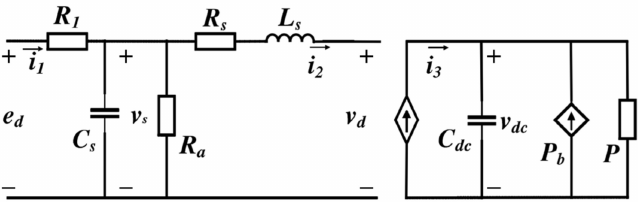
Figure 8. The equivalent model of AC/DC Hybrid Microgrids in discharging.